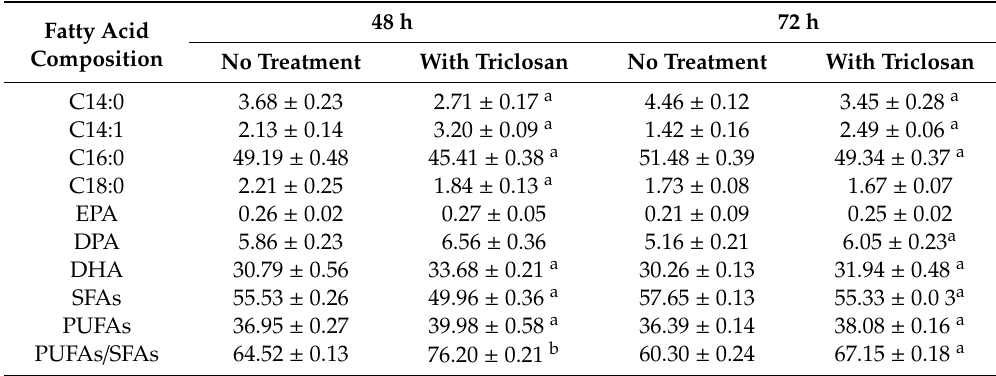
Table 2. Lipid profiles (percentage) at 48 h and 72 h under control condition and 8 µ M triclosan treatment at 24 h. Significant di ff erence between control and triclosan treatment group is indicated at p < 0.05 (a), p < 0.01 (b), or p < 0.001 (c) level. All data are expressed as mean ± S.D. of three independent